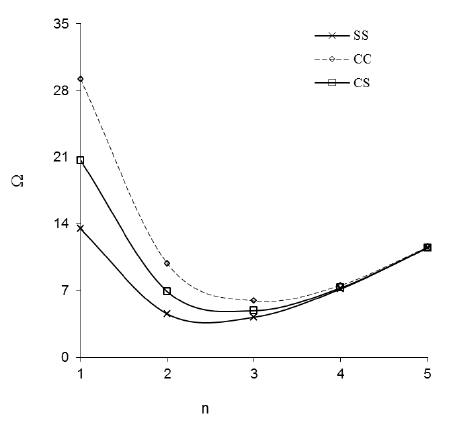
Figure 3: Variation of natural frequency with mode numbers of FGM cylindrical shell with different boundary conditions (m=1; R/h=500;